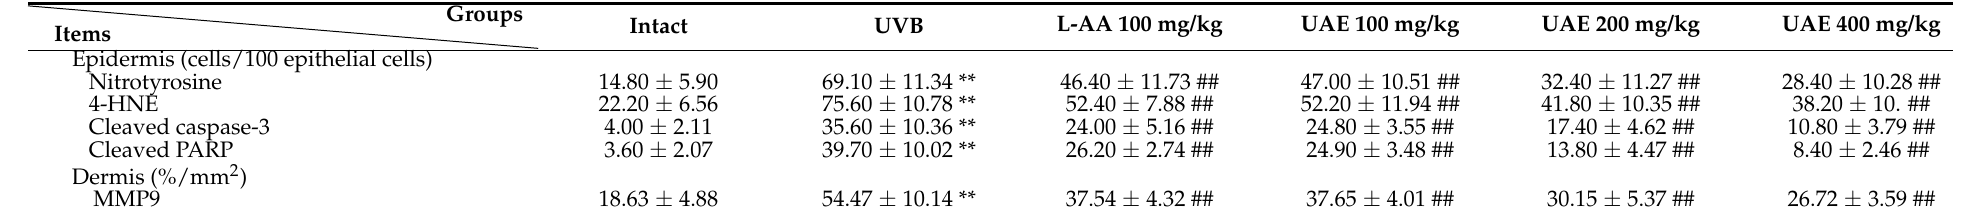
Table 2. Immuno-histological changes in UVB-irradiated dorsal back skin